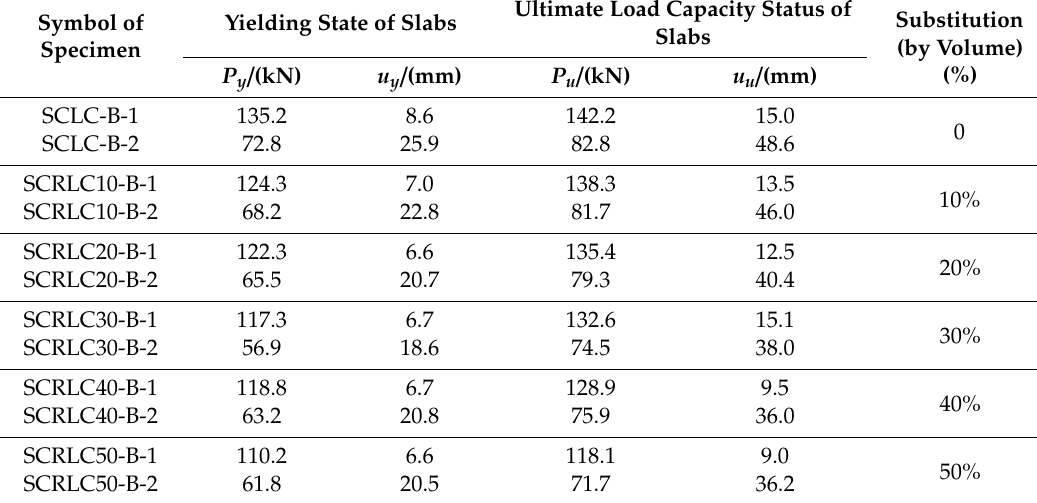
Figure 20. Load–deflection curves of different composite slabs at mid-span by FEA. ( a ) Shear span 450 mm, ( b ) Shear span 800 mm. Table 9. Analysis results of FEA.